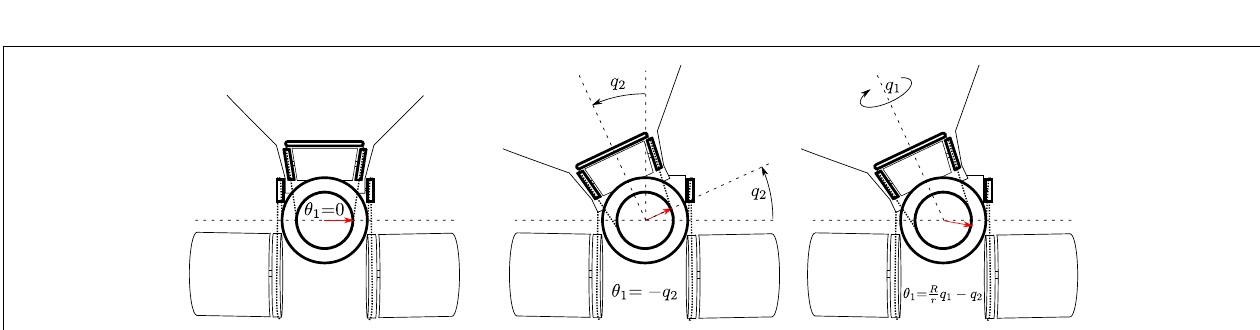
FIGURE 6 |The sketch is used to represent the kinematic coupling between the yaw and roll movements . A roll movement of an angle q 2 implies an equal and opposite movement of the rotor of the motor 0B4M0.This rotor moves, modulo the transmission ratio, also when a yaw movement of an angle q 1 occurs.